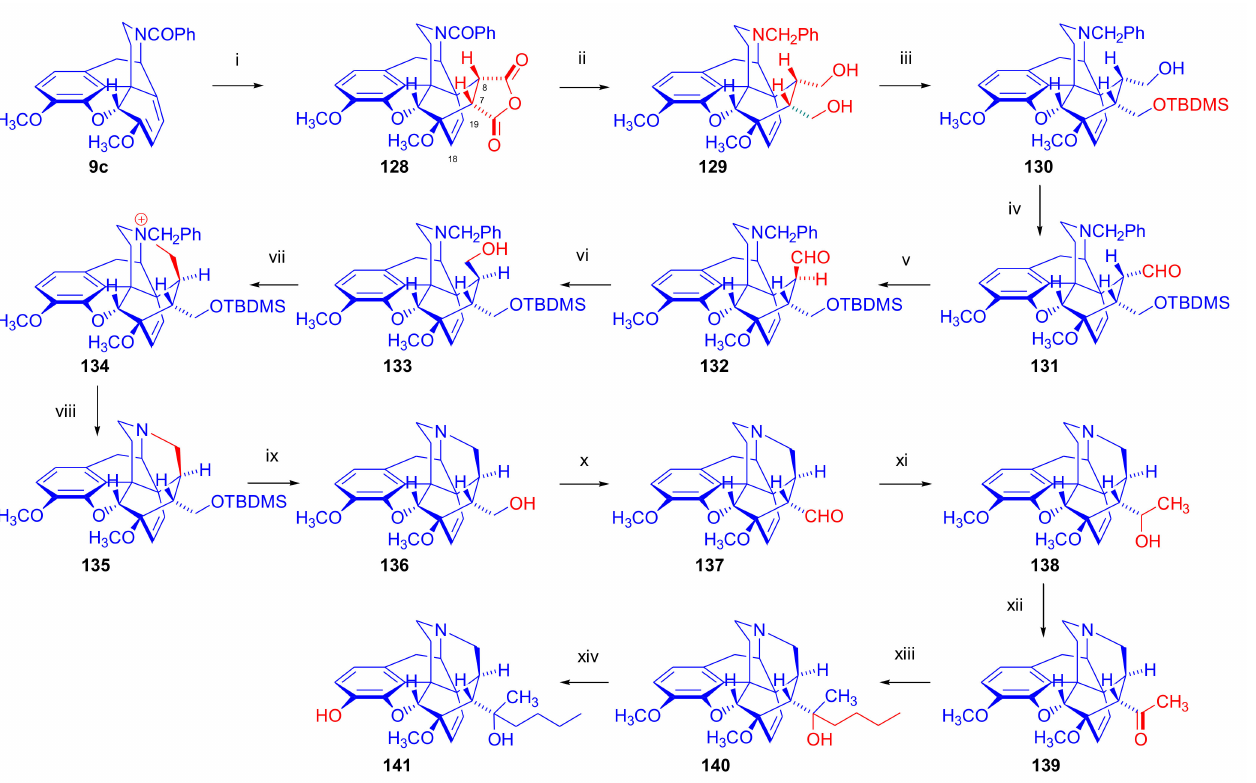
Figure 38. Synthesis of N 17 - C 8 β -methano-bridged homoetorphine. Reagents and conditions : (i):